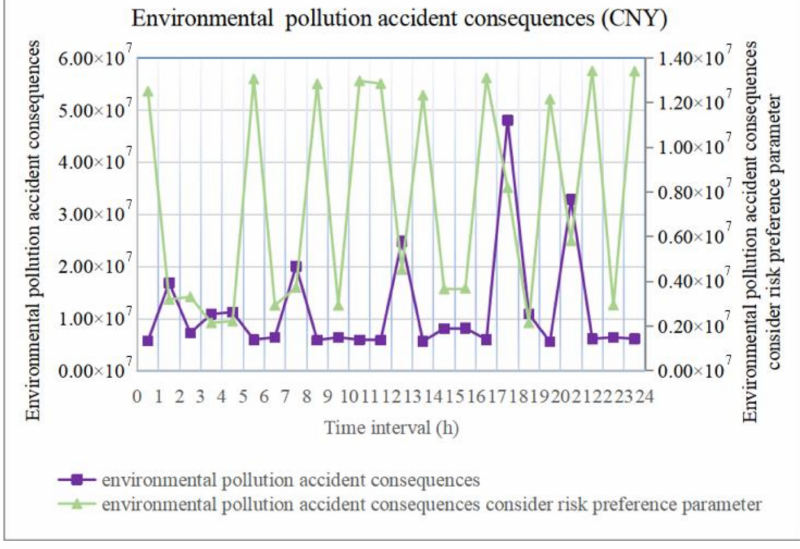
Figure 12. Environmental pollution accident consequences.